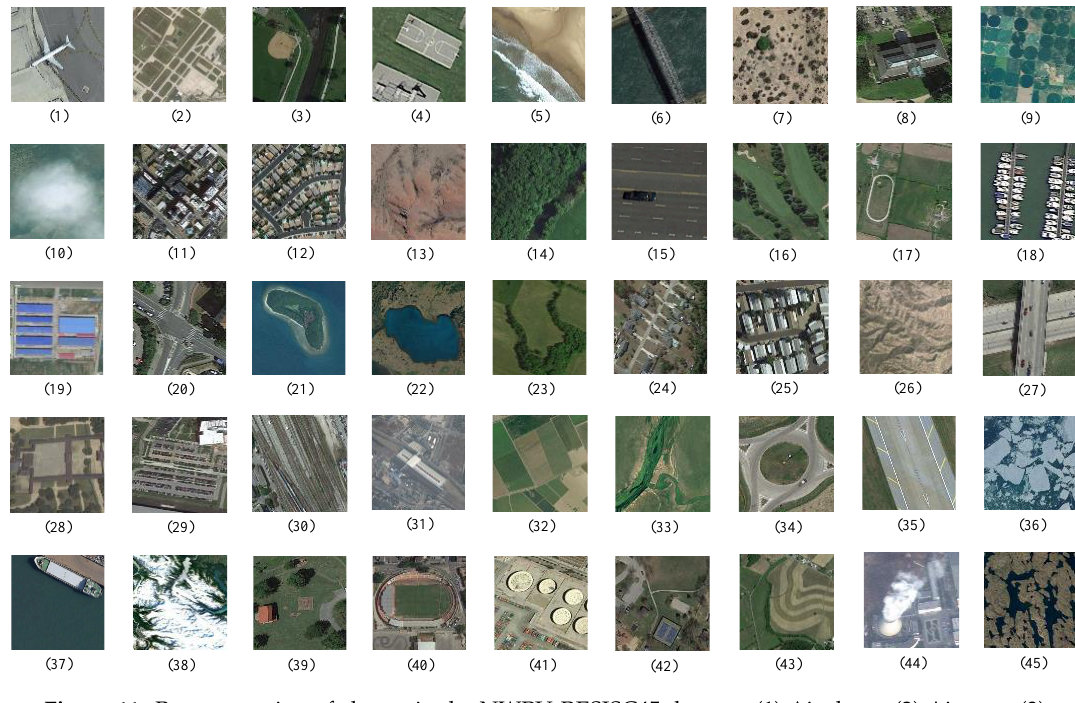
Figure 11. Representation of classes in the NWPU-RESISC45 dataset. (1) Airplane. (2) Airport. (3) Baseball diamond. (4) Basketball court. (5) Beach. (6) Bridge. (7) Chaparral. (8) Church. (9) Circular farmland. (10) Cloud. (11) Commercial area. (12) Dense residential. (13) Desert. (14) Forest. (15) Freeway. (16) Golf course. (17) Ground track field. (18) Harbor. (19) Industrial area. (20) Intersection. (21) Island. (22) Lake. (23) Meadow. (24) Medium residential. (25) Mobile home park. (26) Mountain. (27) Overpass. (28) Palace. (29) Parking lot. (30) Railway. (31) Railway station. (32) Rectangular farmland. (33) River. (34) Roundabout. (35) Runway. (36) Sea ice. (37) Ship. (38) Snowberg. (39) Sparse residential. (40) Stadium. (41) Storage tank. (42) Tennis court. (43) Terrace. (44) Thermal power station. (45) Wetland.